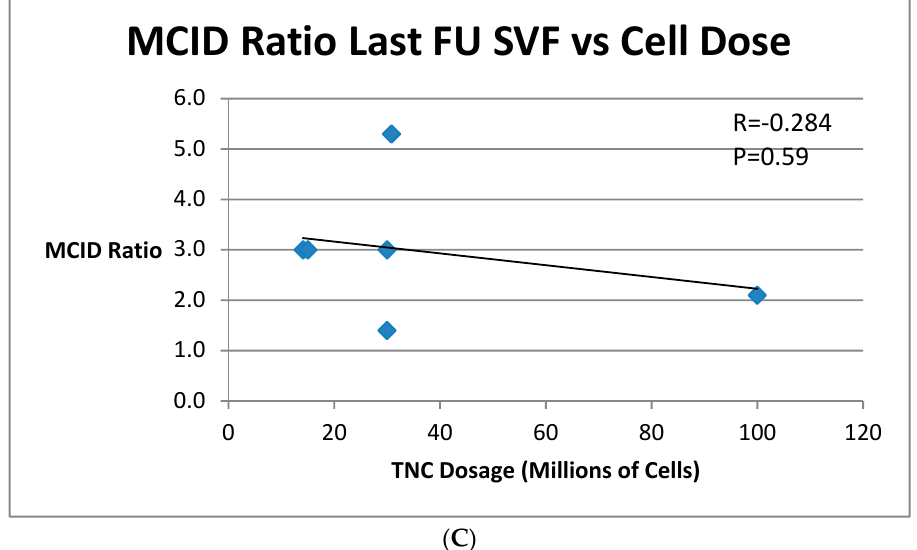
Figure 4. ( A ) MCID Ratio at Last Follow-up for Cultured ASC vs MSC Dose. ( B ) MCID Ratio at Last Follow-up for Cultured BMSC vs MSC Dose. ( C ) MCID Ratio at Last Follow-up for SVF vs TNC Dose.